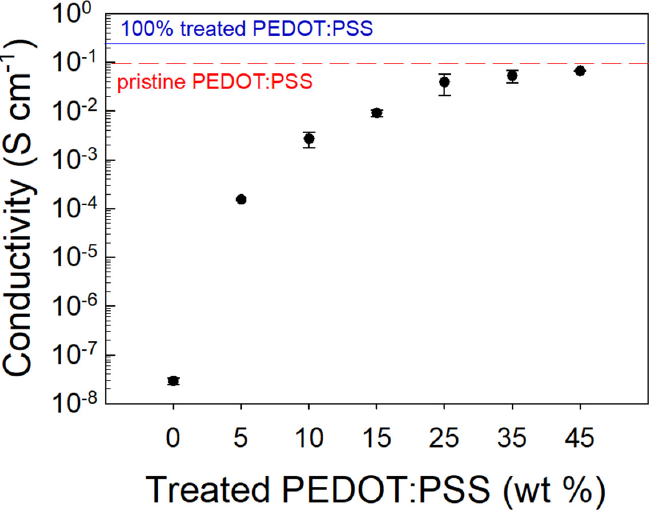
Figure 5. Conductivity of the PEGDA:PEDOT samples at different treated PEDOT:PSS contents.